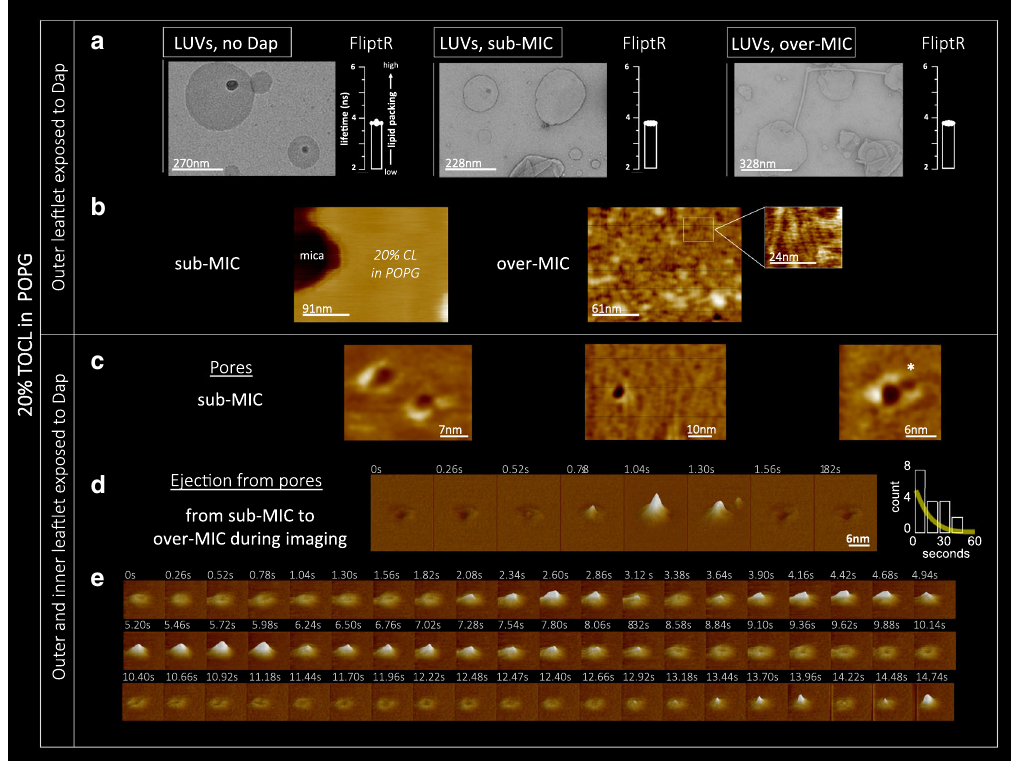
Fig. 7 Dap effect on TOCL(CL)/POPG vesicles and model membrane by TEM, FliptR and HS-AFM. The incorporation of 20% molar of TOCL to the POPG model membrane inhibited Dap action creating CL-speci fi c membrane dynamics. a By TEM, the TOCL/POPG vesicles do not deform at sub-MIC, whereas at over-MIC only minor deformations, scarce tubulations, are formed. By FliptR lifetime (standard deviation error shown), the lipid packing is not altered by Dap. b , left, On TOCL/POPG supported membranes exposed (tens of minutes) on the outer lea fl et to sub-MIC Dap (colour scale: 4 nm), deformations were not observed, but, at over-MIC ( b, right), membrane buckling appeared; periodically distributed lines with a 5 nm pitch reminiscent of a ripple phase (colour scale: 3 nm). The buckling static allowed high-resolution imaging, its substructure was composed of particles of 1.5 nm in diameter; possibly the head groups of Dap and/or TOCL molecules. c TOCL/POPG supported membrane of symmetrized inter-lea fl et Dap distribution; for it, the POPG vesicles opened and adsorbed onto the mica substrate in the presence of Dap in the solution, toroidal pores formed of structure similar to the toroidal pores formed on POPG membranes (colour scale: 2 nm). The toroidal pores in TOCL/POPG showed a tendency to cluster (asterisk). d We induced inter-lea fl et de-symmetrization by exposing the outer lea fl et to supplementary quantities of Dap added to the imaging solution. This induced the activation of a possible membrane tension relief mechanism that, by a cyclic accumulation process seems to eject material out of the membrane; some material appears next to the pore at 1.30 s (Supplementary Movie 3) (Full colour scale: 3 nm). d , right, Histogram of the time-lapses between consecutive accumulations, the time variability spans from hundreds of milliseconds to several seconds, signature of the stochastic nature of the accumulation process. A fi tting to an exponential curve is shown. e The pore recovers its initial state without any visible traces remaining from the material accumulation. Moreover, the symmetrization of Dap inter-lea fl et distribution and the probable ejection of material from the pore caused the disappearance of the bucking deformation from the TOCL/POPG membranes, indicative of a membrane tension relief (Full colour scale: 3